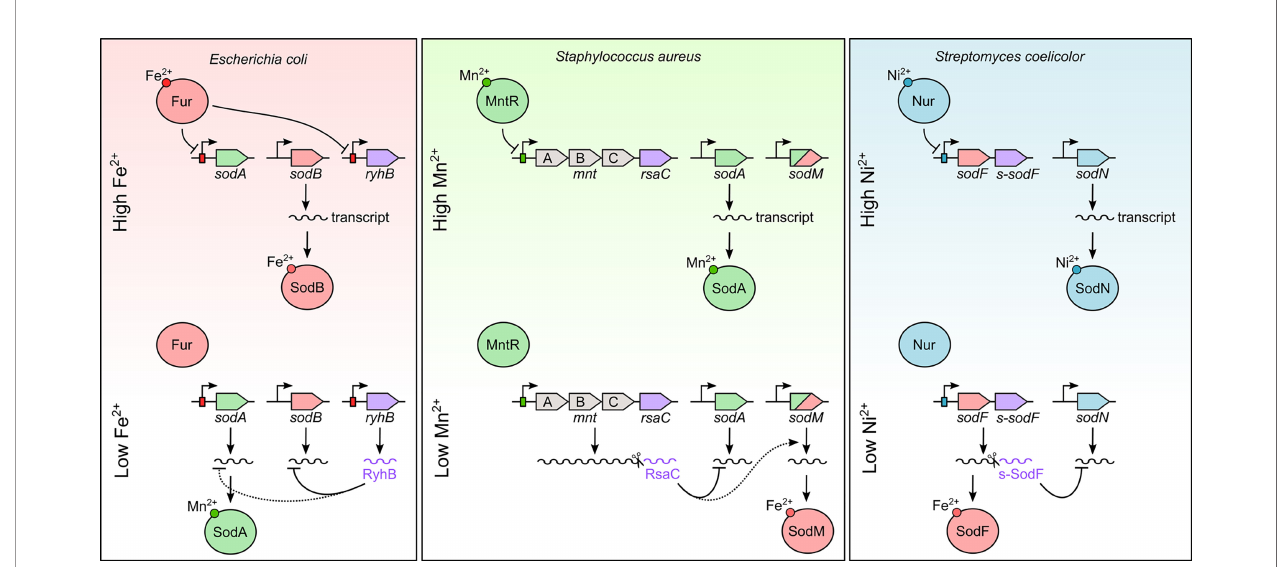
FIGURE 1 | Mixed regulatory circuits between transcription factors and sRNAs to control SOD synthesis according to metal bioavailability. Fur (red), MntR (green) and Nur (blue) boxes are indicated by a rectangle overlapping the promoter. sRNAs are indicated in purple. Dotted lines represent putative or indirect regulation in need of further experimentation. See text for more details.